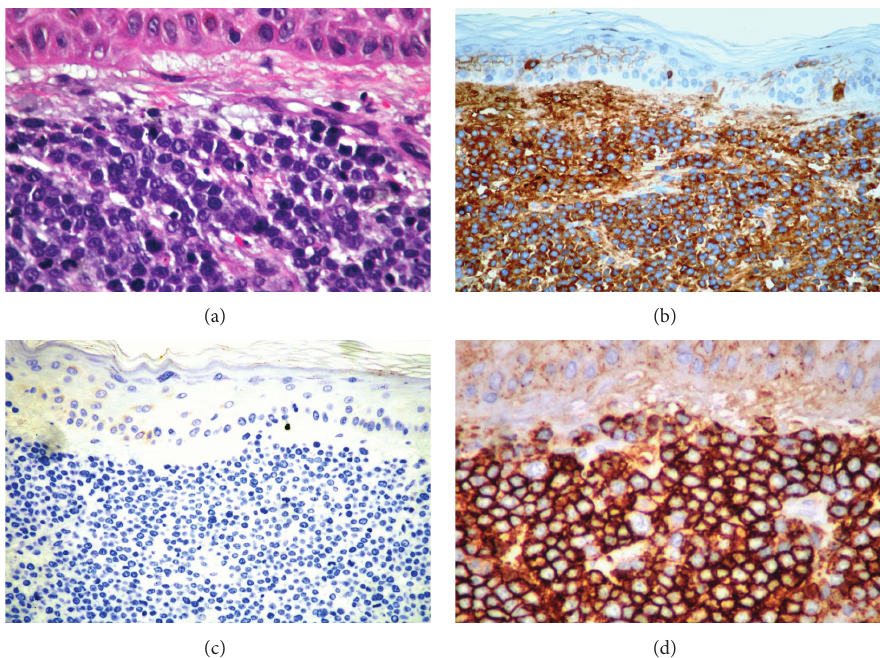
Figure 2: Histopathologic features of biopsy from patient’s right forearm lesion demonstrating: (a) neoplastic plasma cells infiltrating dermis with pleomorphic nuclei on Haematoxylin-Eosin staining, (b) strong lambda light chain staining, (c) lack of kappa light chain expression, and (d) strong staining for CD138 (plasma cell marker).